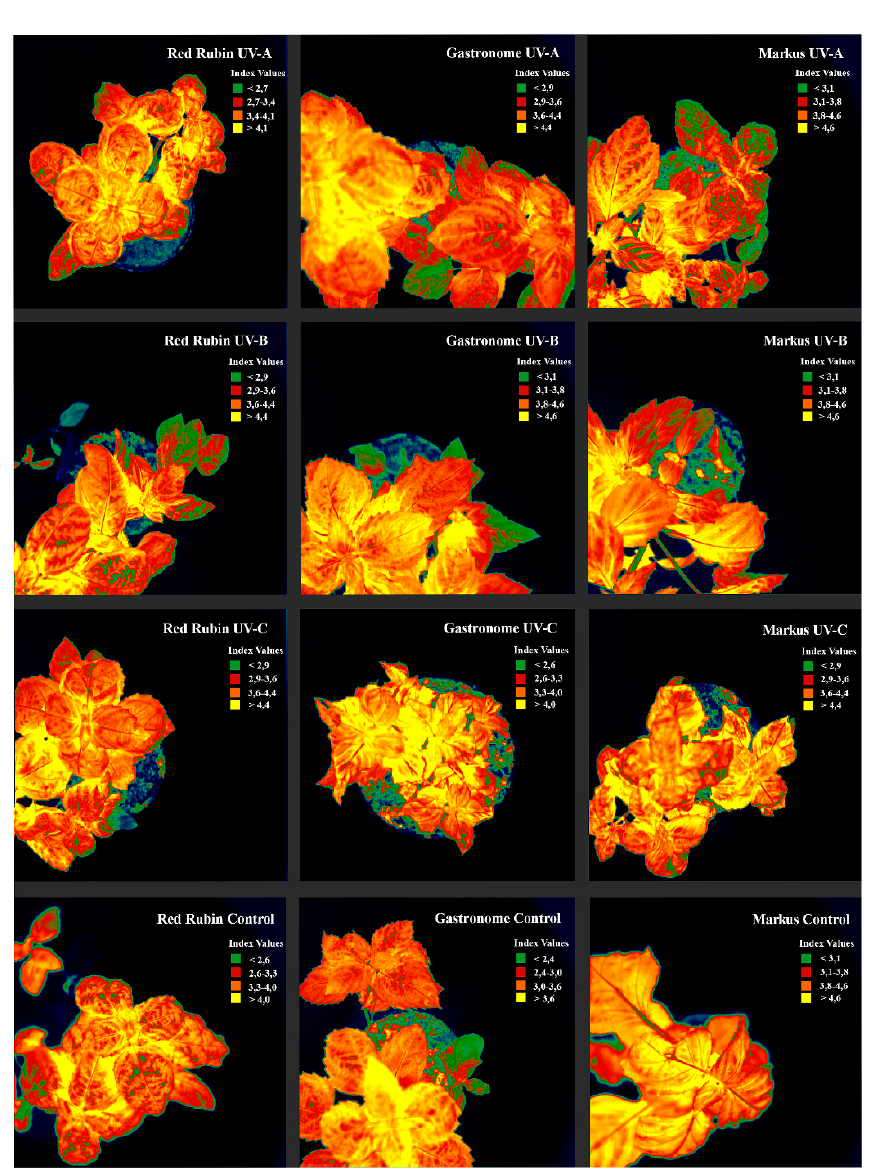
Figure 7. Graphic image of R 750/R700 index of basil leaves in false colors on 30th day of cultivation. Table 3. Average values of vegetative indices for basil varieties “Red Ruby”, “Gastronome” and “Markus” on 30th day of cultivation. Plant Variety Sample